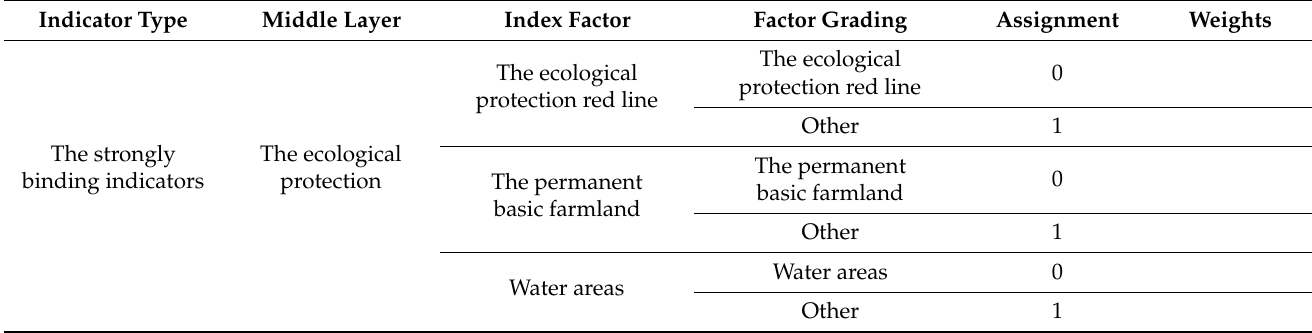
Table 1. Evaluation index system for the appropriateness of township construction